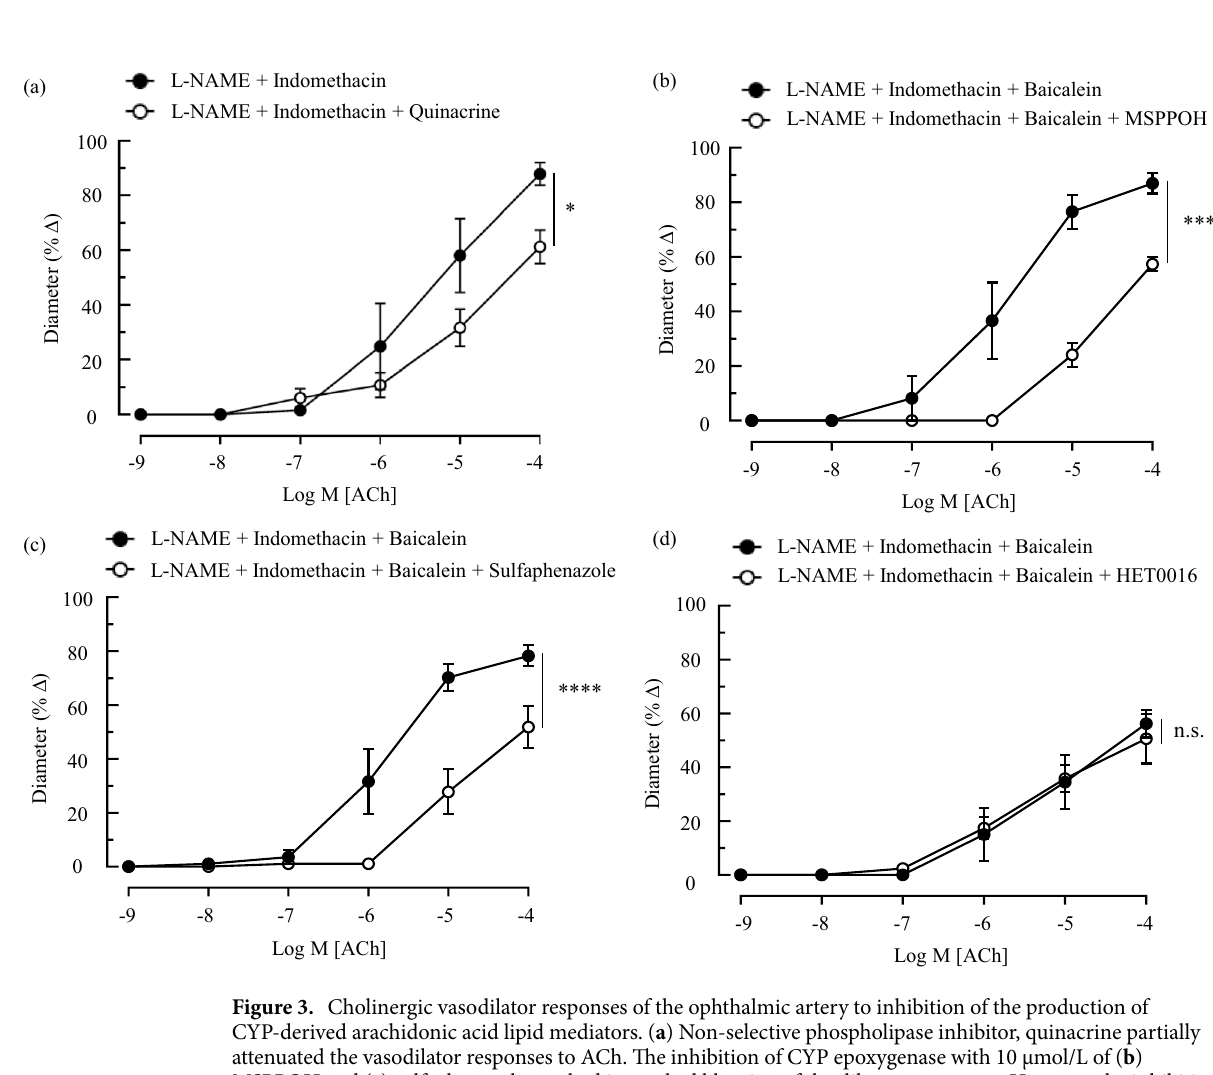
Figure 3. Cholinergic vasodilator responses of the ophthalmic artery to inhibition of the production of CYP-derived arachidonic acid lipid mediators. ( a ) Non-selective phospholipase inhibitor, quinacrine partially attenuated the vasodilator responses to ACh. The inhibition of CYP epoxygenase with 10 µmol/L of ( b ) MSPPOH and ( c ) sulfaphenazole resulted in marked blunting of the dilatory responses. However, the inhibition of CYP ω-hydroxylase with ( d ) HET0016 (1 µmol/L) conferred negligible inhibitory effects on ACh-induced vasodilation. Values are expressed as mean ± standard error of the mean (s.e.m), n = 6 per group. Absence of error bar indicates that the s.e.m was less than the size of the symbol. * P < 0.05 vs. L-NAME + indomethacin; **** P < 0.0001, n.s. non-significant, vs. L-NAME + indomethacin +